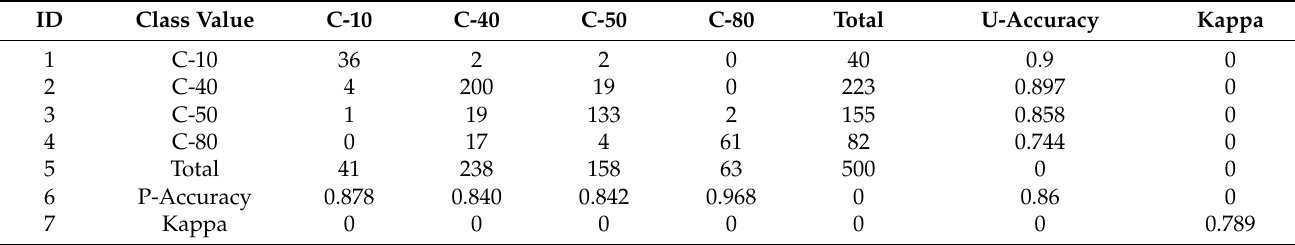
Table A4. ArcGIS Pro confusion matrix of the SVM classification map generated from SfM